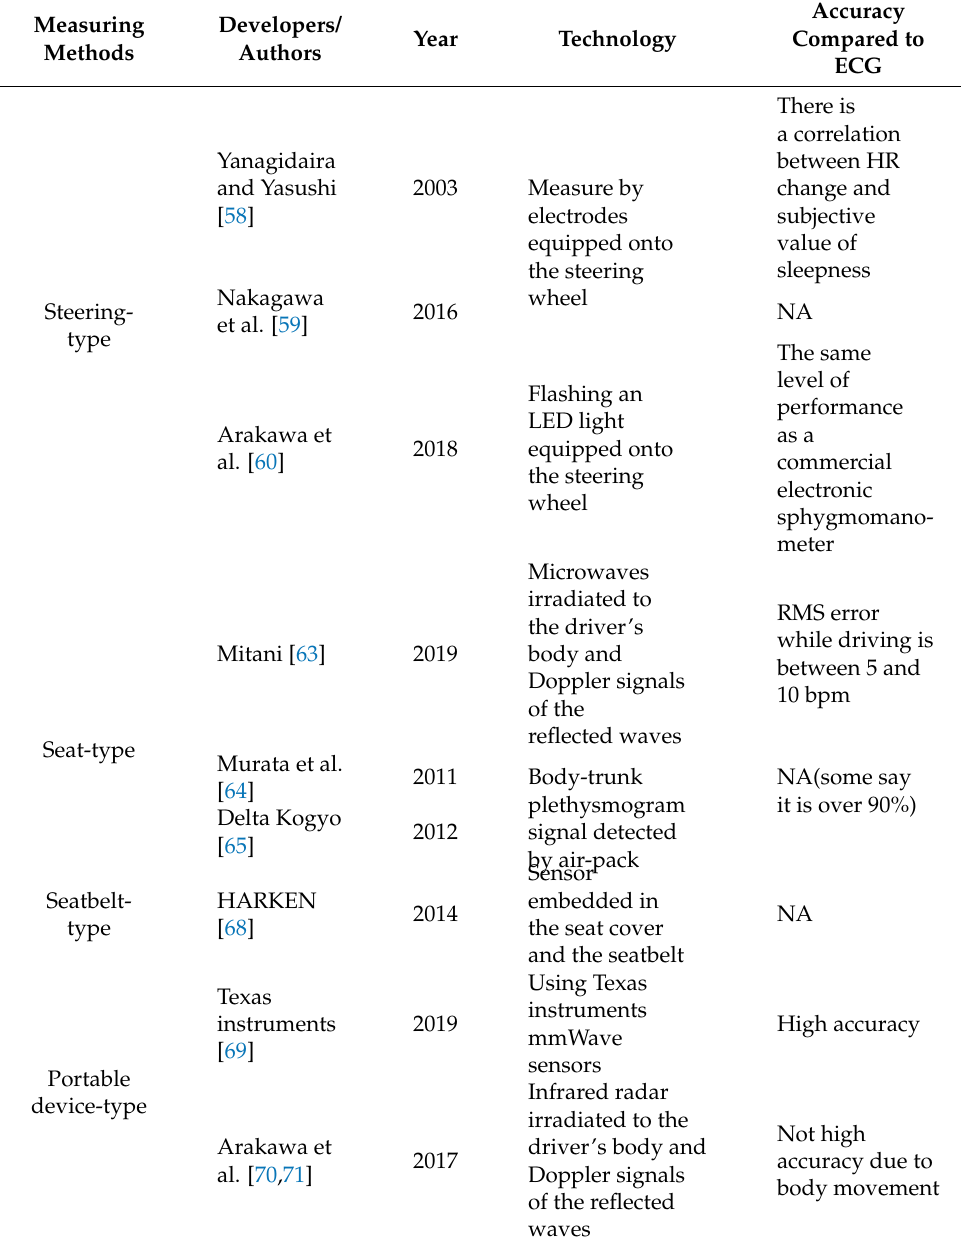
Table 4. Comparison table of nonwearable-type heartbeat measuring methods in this review. NA means that no description of accuracy can be